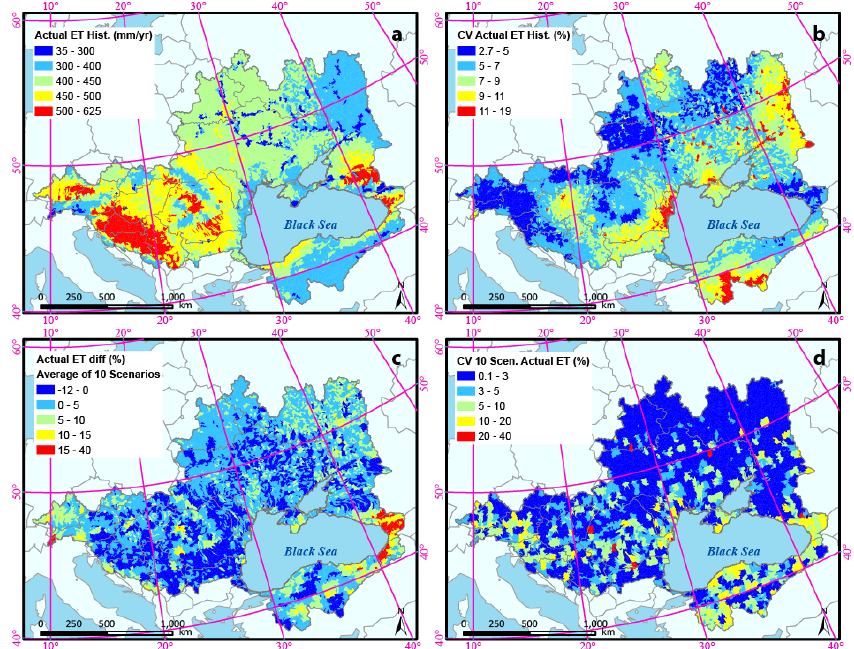
Figure 9. Spatial distribution of green water flow (evapotranspiration) in the Black Sea Catchment: ( a ) long-term historical average (1973–2006); ( b ) temporal variation of the green water flow (1973–2006); ( c ) percent deviation of the future green water flow (2020–2050) from historic (1973–2006) based on the ensemble of 10 scenarios; ( d ) coefficient of variation of actual evapotranspiration among the 10